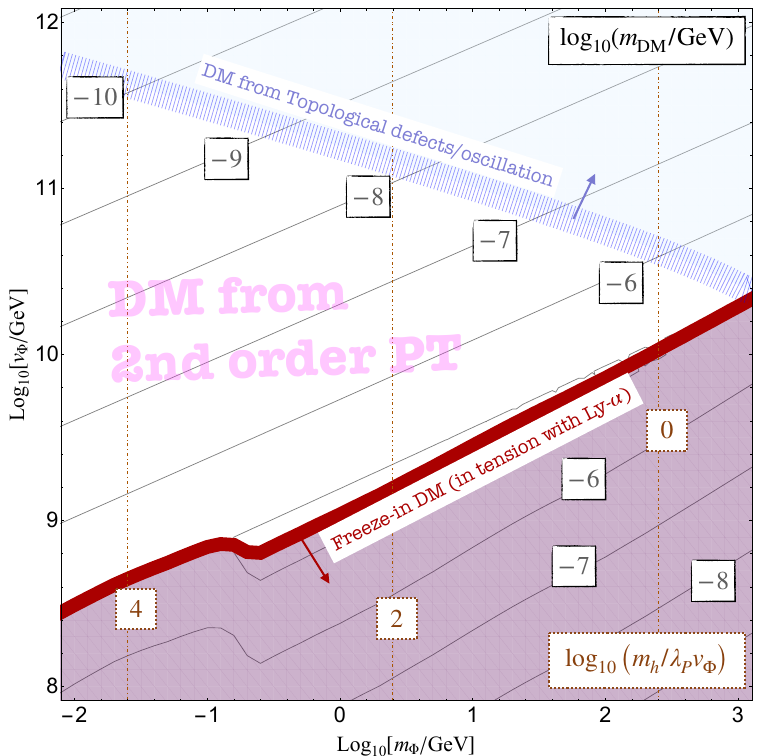
Figure 3 . The contours for the lightest possible DM mass in ( m Φ , v Φ ) plane. The vertical dot- dashed contours in orange denote the amount of fine-tuning to the SM Higgs boson mass, m h /λ P v Φ . Various constraints discussed in the main part are included. The DM could be either an ALP or hidden photon. Below the red line the DM is mostly produced from the freeze-in mechanism which is in tension with the Lyman α data. Above the blue dashed band the topological defect/coherent oscillation may be